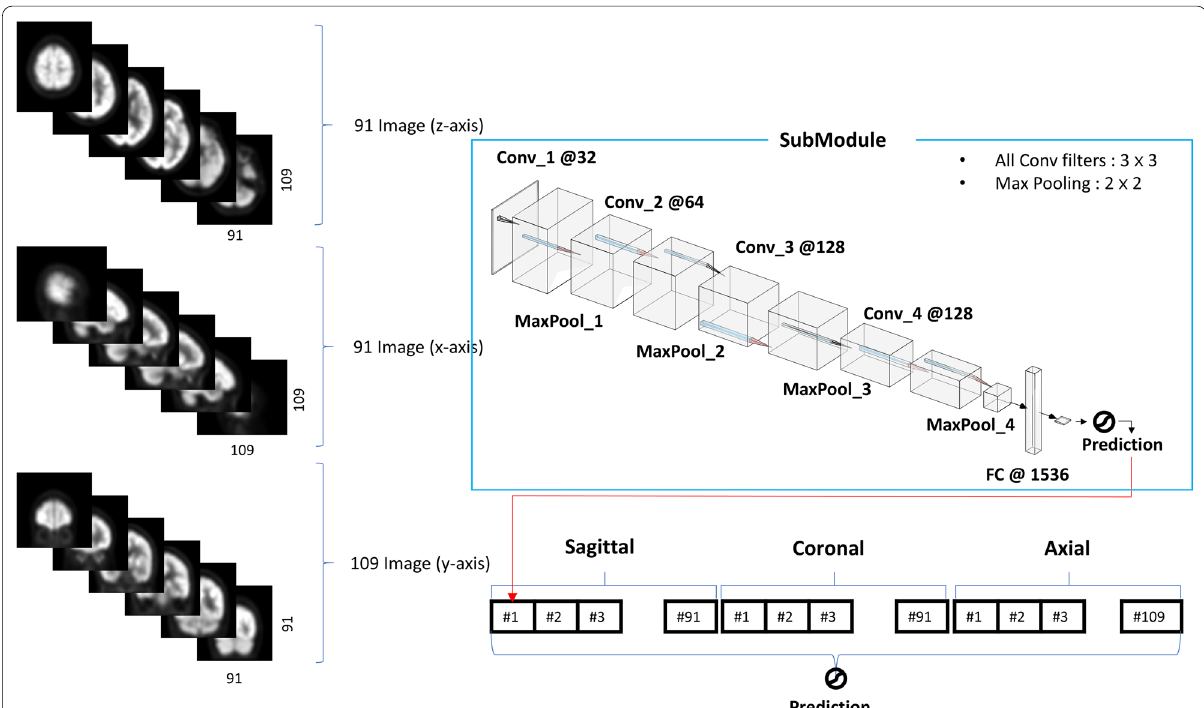
Fig. 2 Convolutional neural network architecture in 2.5 dimensions (2.5-D). A total of 291 2-D images were used as inputs for the model. 291 number of prediction values obtained from 291 submodules pass through the fully connected layer for the final prediction. Abbreviation: Conv convolution layer; MaxPool Max p ooling layer; FC fully connected = = =